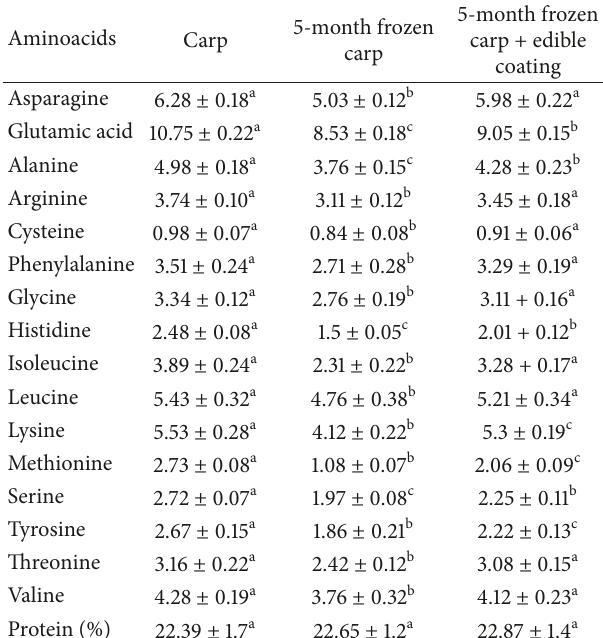
Table 1: Aminoacid composition of common carp fillet proteins, 5- monthfrozencarp,and5-monthfrozencarp+ediblecoating,stored at − 18 ∘